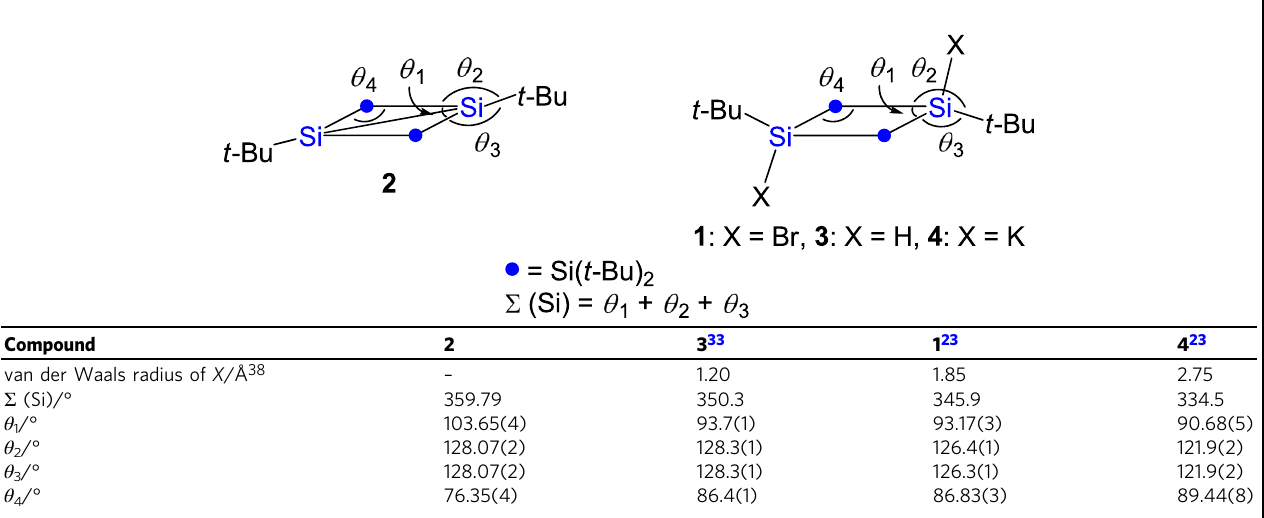
Table 1 Comparison of X-ray structural parameters of 1 –